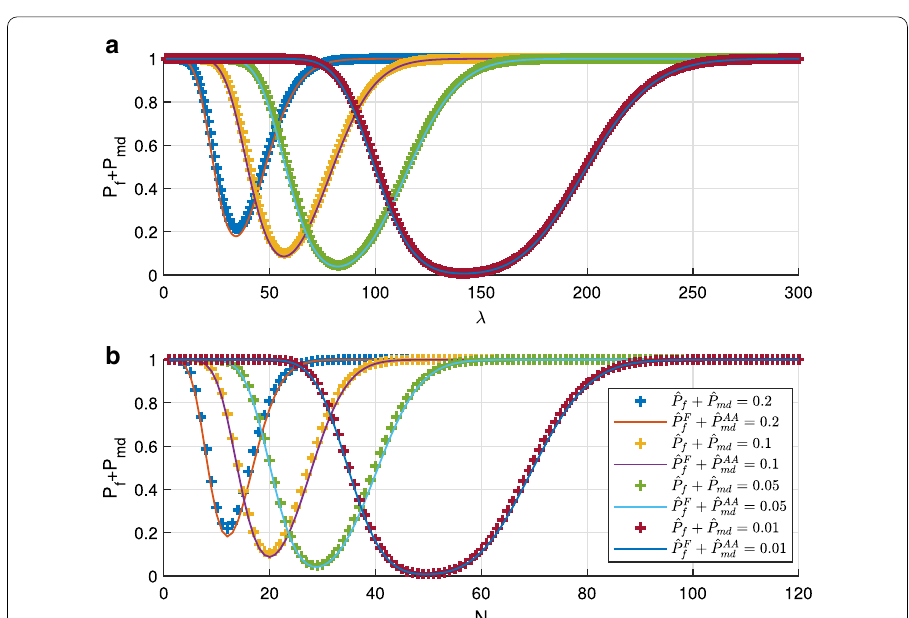
P md simulated, using original equations and approximations, depending on +